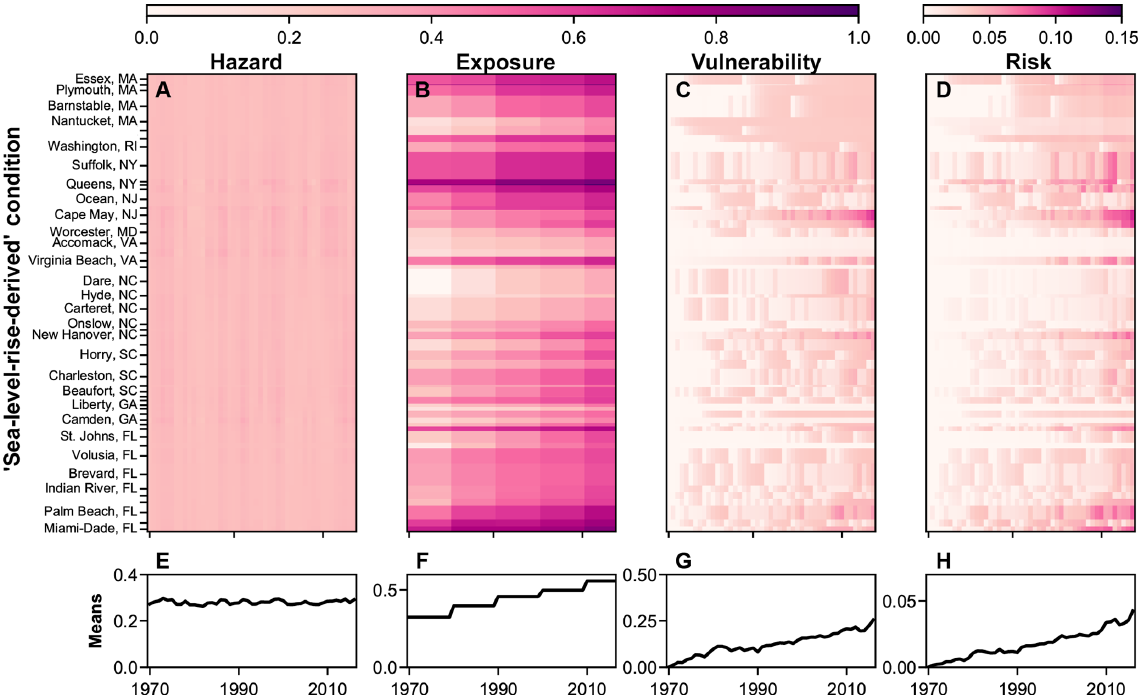
Figure 4. County-scale component (a) hazard, (b) exposure, (c) vulnerability, and (d) overall risk evolution over time and (e–h) corresponding means, using shoreline-change rates derived from sea-level change as the hazard condition. Each county is scaled by the number of 1km transects it comprises; not all counties are